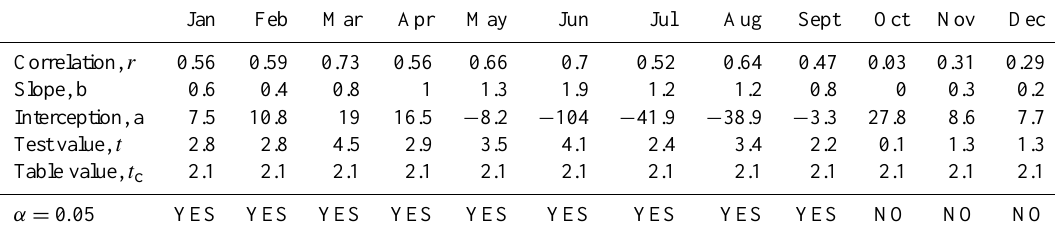
Table 2. Comparison of potential evapotranspiration calculated by the Thornthwaite and the Penman–Monteith methods.